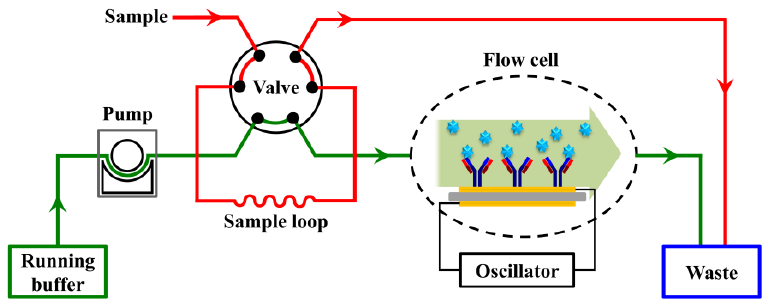
Figure 1. Schematic of the QCM (quartz crystal microbalance) biosensor flow-through